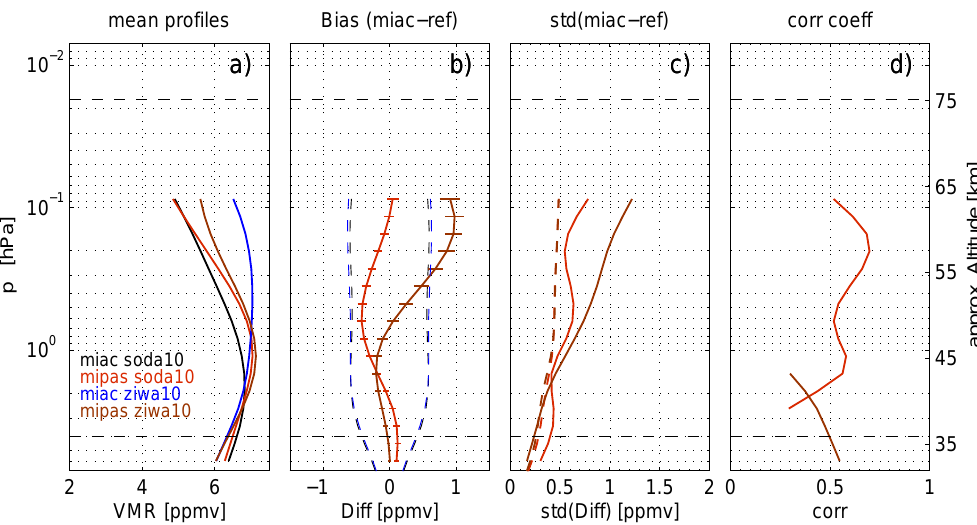
Fig. 11. Intercomparison MIAWARA-C – MIPAS for Sodankyl¨a10 (red) and Zimmerwald10 campaign (brown). (a) Mean coincident pro- files for Sodankyl¨a10 (MIPAS: red, MIAWARA-C: black) and for Zimmerwald10 (MIPAS: brown, MIAWARA-C: blue). (b) Bias (solid – Sodankyl¨a10: red, Zimmerwald10: brown) with standard error (horizontal) together with the estimated systematic error of MIAWARA-C (Sodankyl¨a10: black, Zimmerwald10: blue). (c) Standard deviation of differences (solid) and combined random error of the instruments (dashed): red for Sodankyl¨a10 and brown for Zimmerwald10 campaign. (d) Correlation coefficients. All plots use MIAWARA-C data with AoA > 0.5. The dashed horizontal lines indicate the reliable altitude range (AoA >